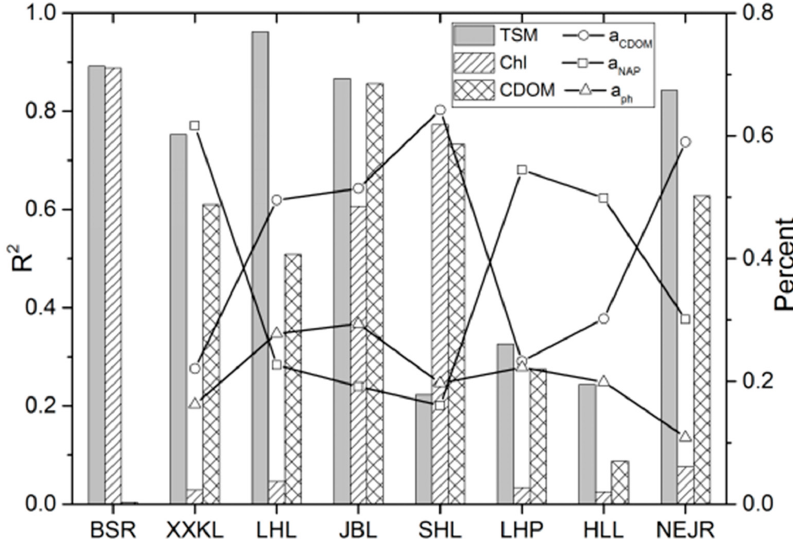
Figure 6. The bars represent the determination coefficients (R 2 ) of the linear regression analysis between the OACs and the K d (PAR). The lines represent the relative contribution of phytoplankton (a ph ), non-algal particles (a NAP ) and CDOM (a CDOM ) to the total absorption. Abbreviations of the lakes correspond to those in Table 1 and are represented on the x-axis.